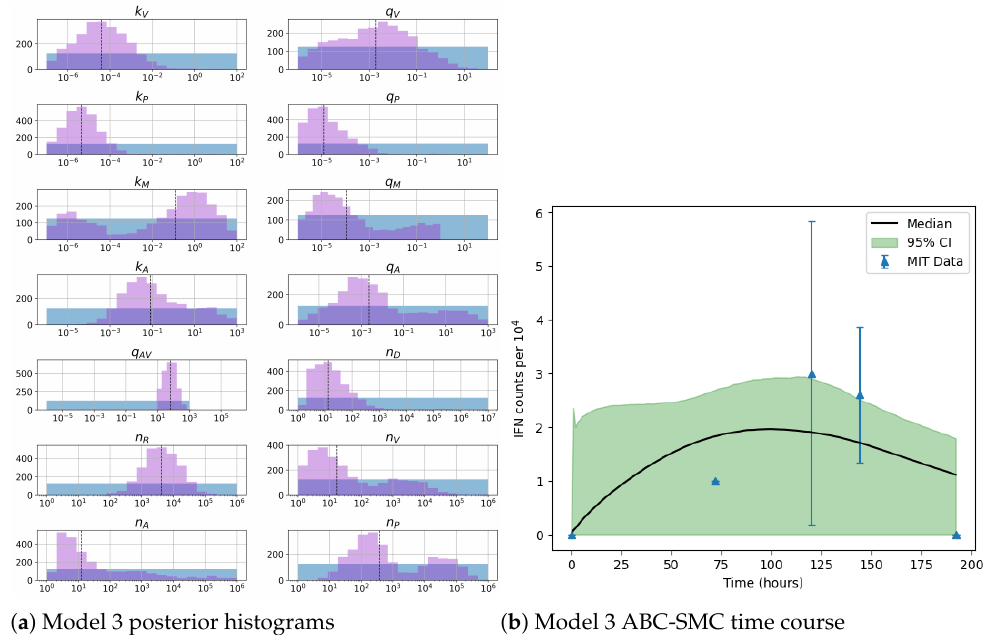
Figure 10. ( a ) Posterior histograms obtained from the ABC-SMC algorithm. Blue histograms indicate prior distributions and purple histograms illustrate posterior ones. ( b ) Model fit from accepted parameter sets obtained during the final iteration of the ABC-SMC algorithm. Blue triangles represent data presented in Table 1 plotted with its standard deviation. The black line illustrates the point-wise median value from accepted parameter sets (shaded in green) with a 95% credible interval. These results represent 18 iterations with 2500 accepted parameter sets for model 3.